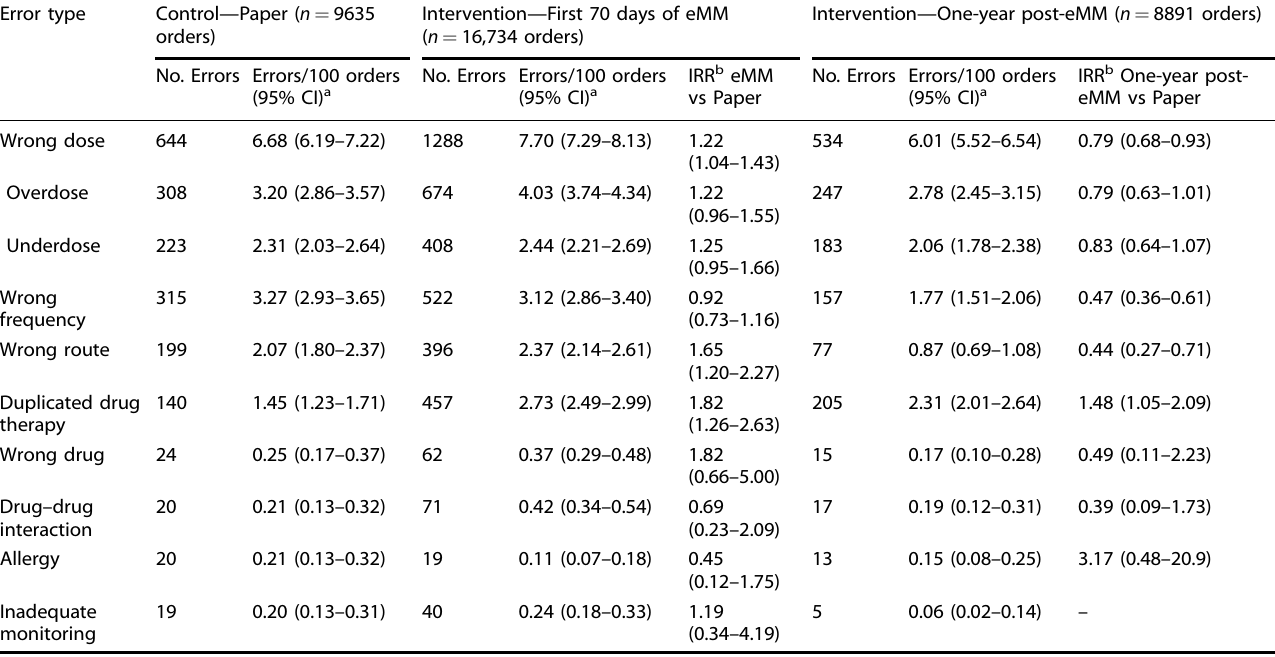
Table 4. Clinical prescribing error rates by type and changes over study periods.